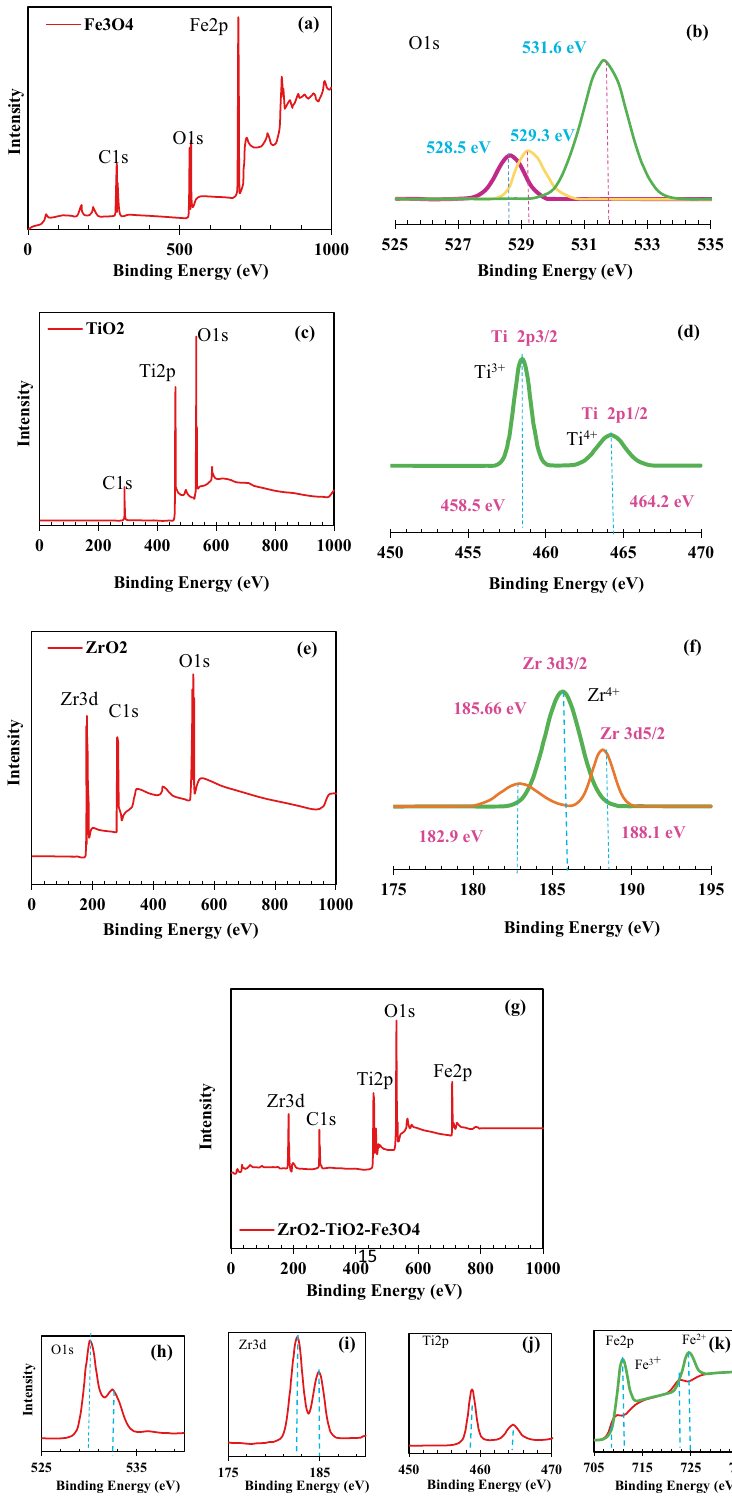
Figure 6. XPS analysis of Nanoparticles ( a ) Fe 3 O 4 , ( b ) The O1s level spectrum, ( c ) TiO 2 , ( d ) The Ti 2p level spectrum, ( e ) ZrO 2 , ( f ) The Zr 3d level spectrum, and ( g ) Nanocomposite of ZrO 2 /TiO 2 /Fe 3 O 4 , XPS spectrum of ( h ) The O1s level ( i ) The Zr 3d level ( j ) The Ti 2p level and (k) The Fe 2p